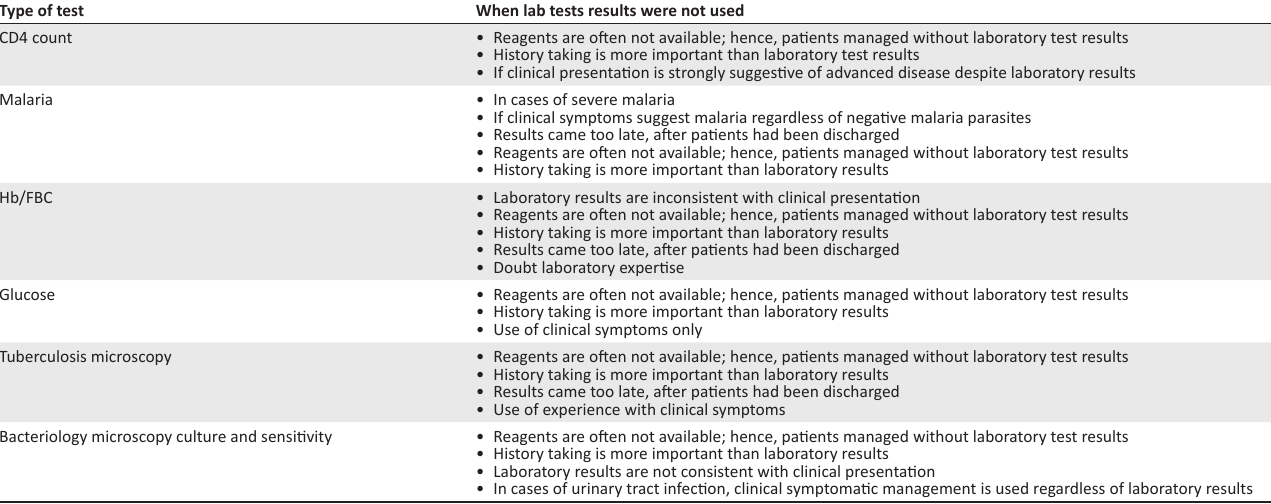
TABLE 4: Scenarios in which clinicians in Malawi did not use laboratory test results, October-November